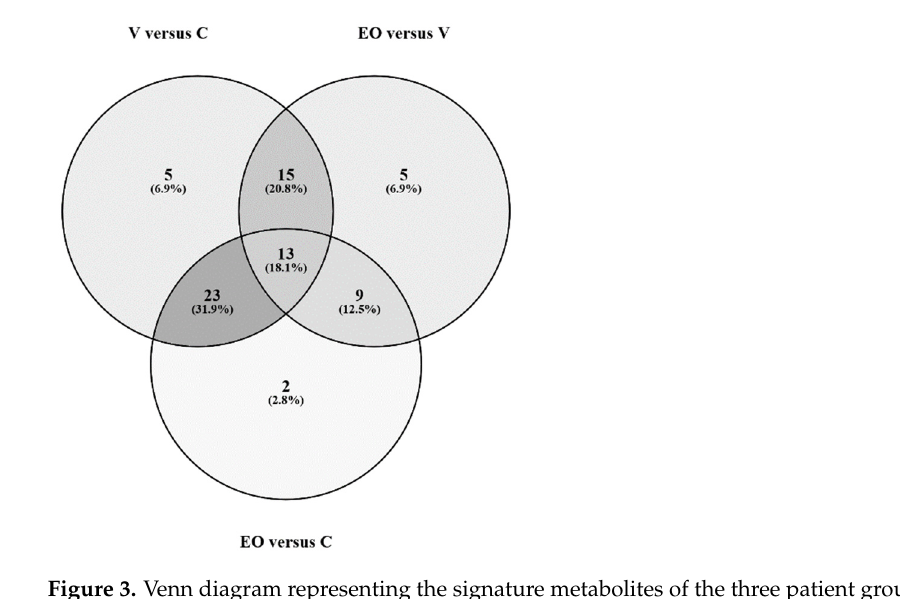
Figure 3. Venn diagram representing the signature metabolites of the three patient groups follow- pairwise comparison. This diagram was made using: ing pairwise comparison. This diagram was made using: https://bioinfogp.cnb.csic.es/tools/venny/ accessed on 5 December 2022.